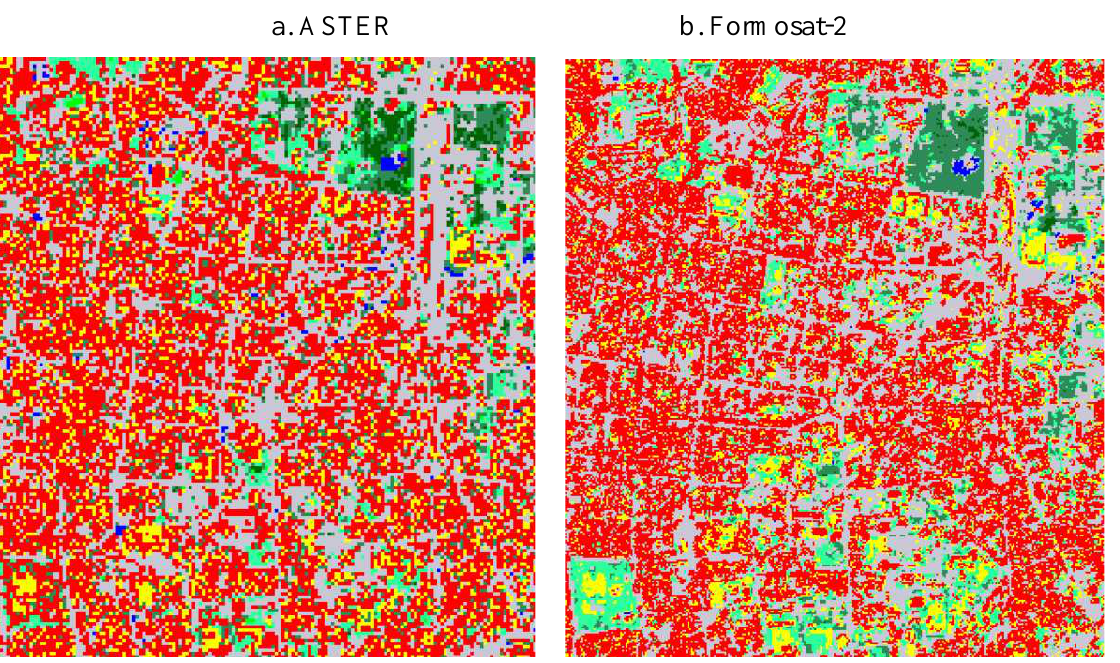
Figure 3. Surface classification maps in a portion of the urban area derived from (a) ASTER and (b) Formosat-2. Color legend is the same as Figure